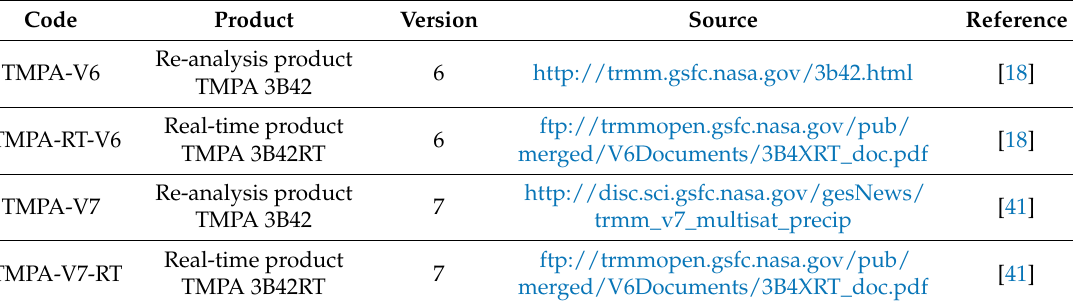
Table 4. Types and sources of the TMPA products used in this